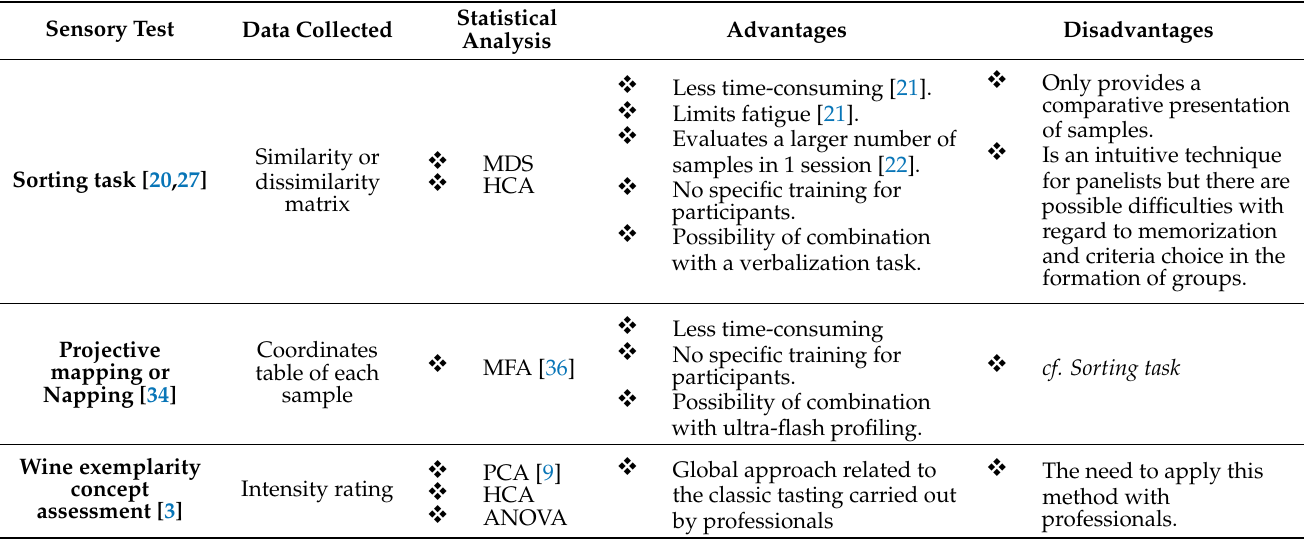
Table 1. Inventory of perceptual methodologies used to evaluate sensory space. Statistical analysis—MDS: multi- dimensional scaling; HCA: hierarchical cluster analysis; MFA: multiple factor analysis; PCA: principal component analysis; ANOVA: analysis of variance.